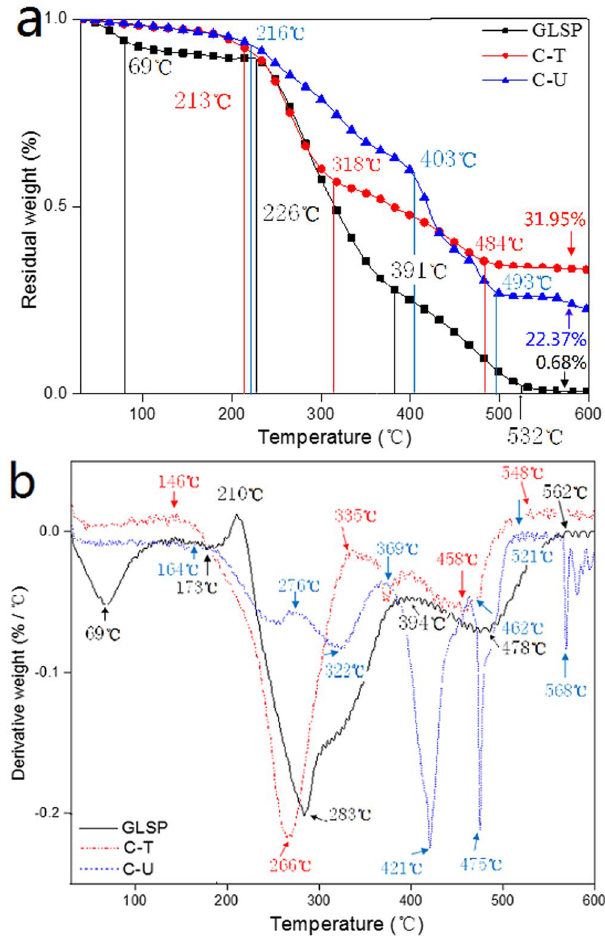
Figure 4. TGA analysis for GLSP, C-T and C-U. ( a ) Change in residual weight vs . temperature, ( b ) derivative weight vs .